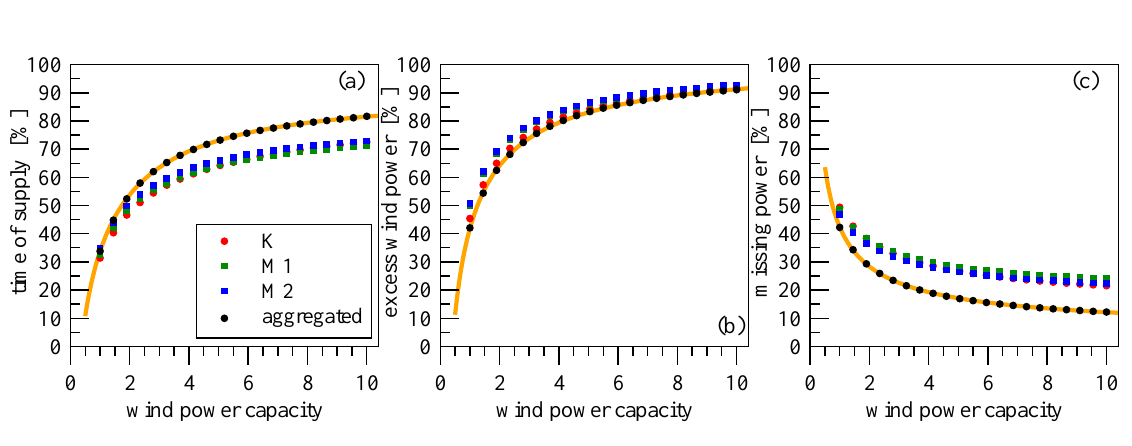
Figure 7. (a) Total time of supply T as a function of installed wind power capacity [ex- S pressed through factor F in Equation (3)] for the individual and aggregated wind